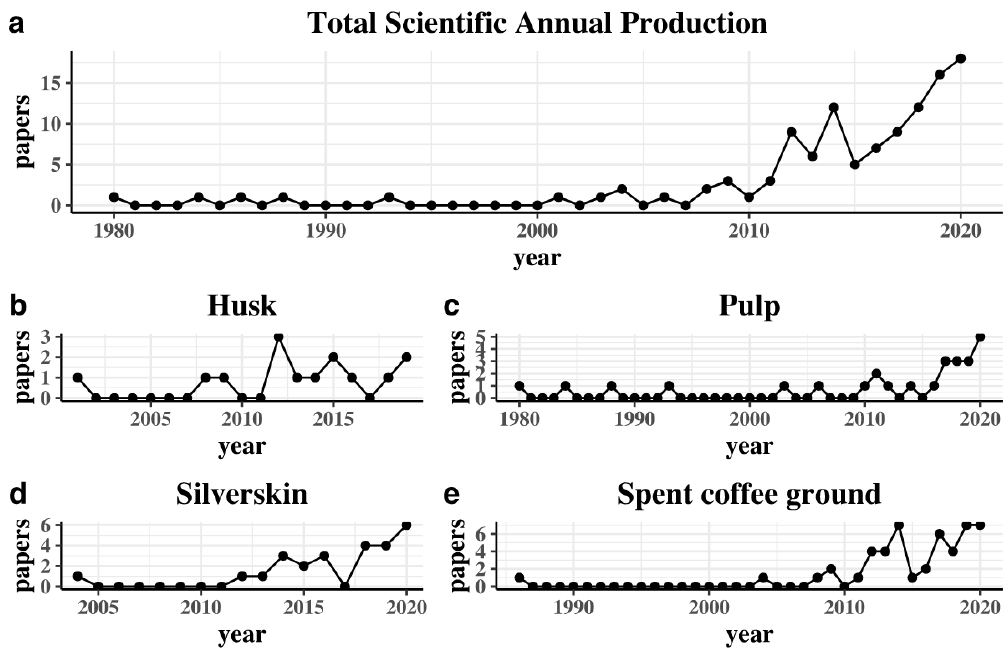
Figure 2. Scientific annual production of coffee by-products. ( a ) Total production, ( b ) Coffee Husk (CH), ( c ) Coffee Pulp (CP), ( d ) Coffee Silverskin (CS), ( e ) Spent Coffee Grounds (SCG).